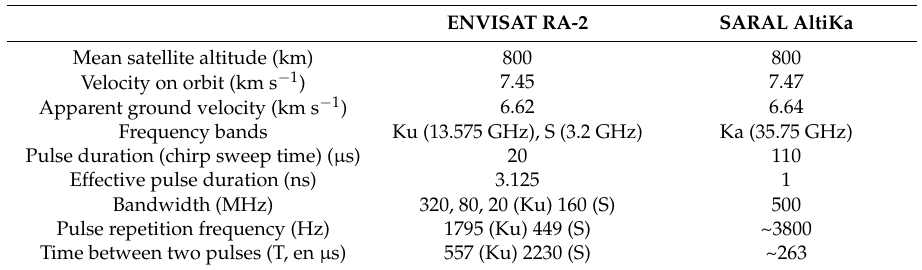
Table 1. Main characteristics of ENVISAT and SARAL altimetry missions and of RA-2 and AltiKa sensors from